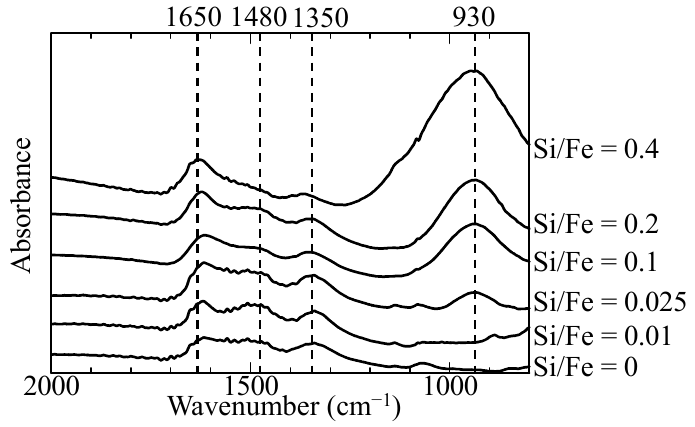
Figure 2. Fourier transform infrared (FTIR) spectra of the initial synthetic precipitates with different Si/Fe ratios.